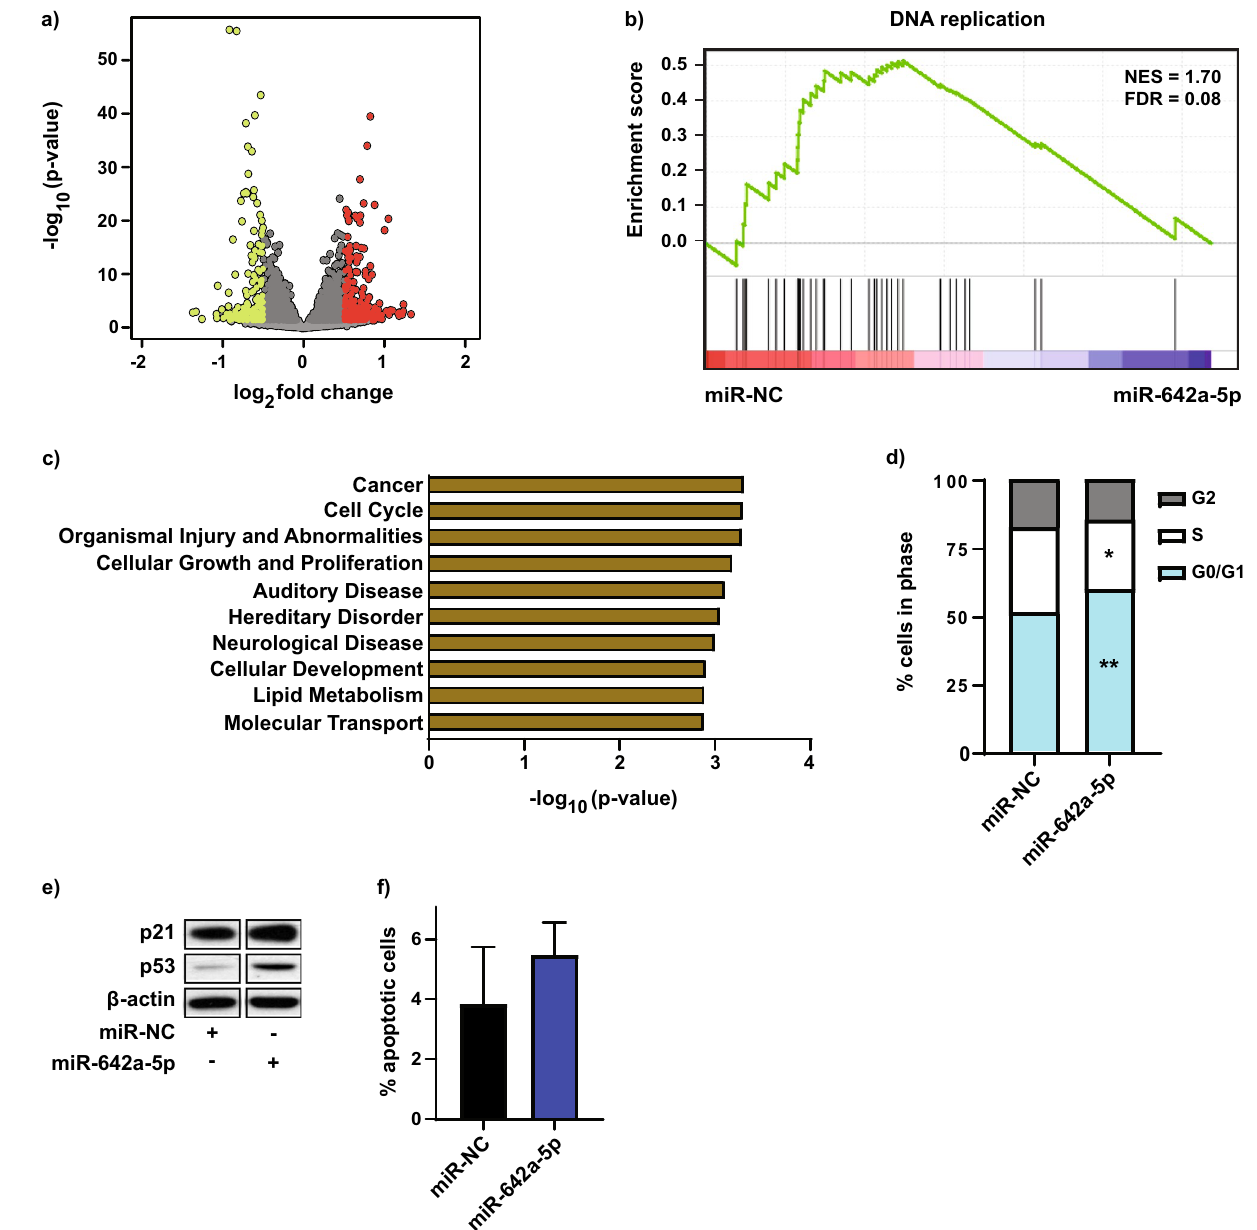
Figure 2. miR-642a-5p targets genes and pathways involved in DNA replication and cell cycle arrest. ( a ) Volcano plot of RNA-Seq results, with green dots representing genes downregulated, and red dots representing genes upregulated (≥ 0.5 log 2 fold change; p < 0.05) by miR-642a-5p. ( b ) Gene Set Enrichment Analysis (GSEA) of the RNA-Seq data. The y-axis and the green line show the enrichment score for each gene, illustrated as a vertical line plotted in rank order of the most gene abundance (red, left) to the least gene abundance (blue, right) within the indicated samples (as log 2 FC/comparison); the black vertical lines correspond to member genes from the set. NES normalized enrichment score, FDR false discovery rate. ( c ) Ingenuity Pathway Analysis of the miR-642a-5p up and downregulated genes. Pathways ranked by the p value result of a Fisher’s exact test. ( d ) Flow cytometry cell cycle analysis of 22Rv1 cells transfected with miR-642a-5p or miR-NC (30 nM) for 72 h. n = 3; * p < 0.05, ** p < 0.005 relative to miR-NC. ( e ) Western blot analysis of p21 and p53 protein expression 72 h post-transfection of 22Rv1 cells with 30 nM miR-642a-5p or miR-NC. β-actin is the loading control. Bands are from non-adjacent lanes of the same western blot and are separated by white space (see Supplementary Fig. S1A for uncropped blots, which were cut into smaller strips prior to immunoblotting). n = 3. ( f ) Flow cytometry apoptosis analysis of 22Rv1 cells transfected miR-642a-5p or miR-NC (30 nM) for 72 h. Error bars = SD; n = 3; p >